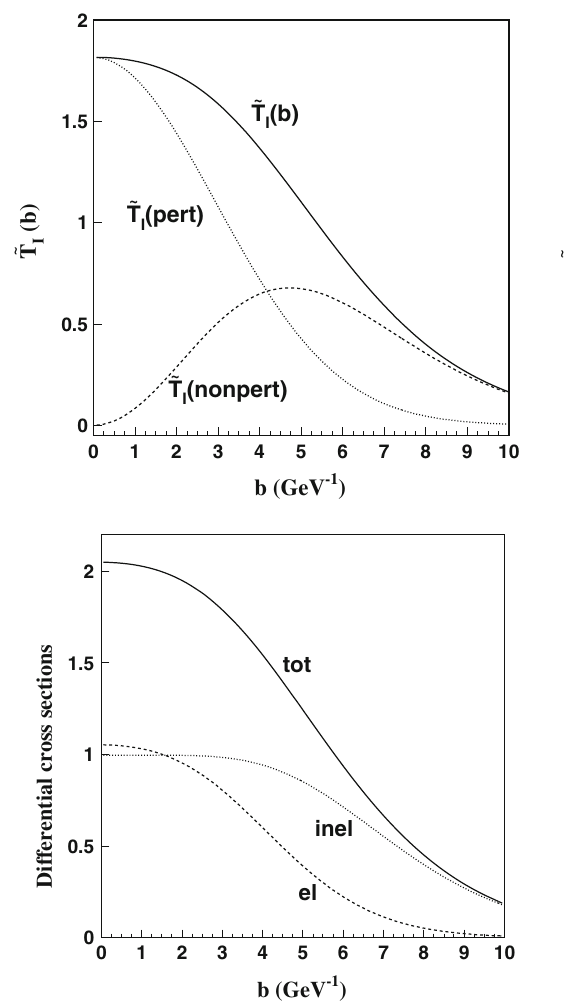
Fig. 8 a , b Amplitudes in b-space. The quantities labelled in the fig- ures are (cid:2) T K ( pert ) = (α K / 2 β K ) e − b 2 / 4 β K , (cid:2) T K ( nonpert ) = λ K (cid:2) ψ K ( b ) , with (cid:2) ψ K ( b ) giveninEq.(2),and (cid:2) T K = (cid:2) T K ( pert ) + (cid:2) T K ( nonpert ) .Notice the difference in the scales of the plots of (cid:2) T I and (cid:2) T R . The perturbative